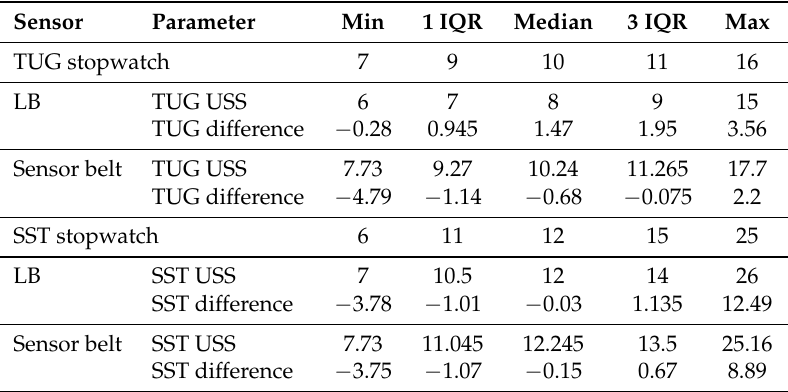
Table 4. Characteristics of the measures in seconds. Overall, 91 participants were considered. LB: Light Barriers, IQR: Interquartile Range, Min: Minimum, Max: Maximum, TUG: Timed “Up & Go” Test, 5xSST: Five Times Sit-to-Stand Test.